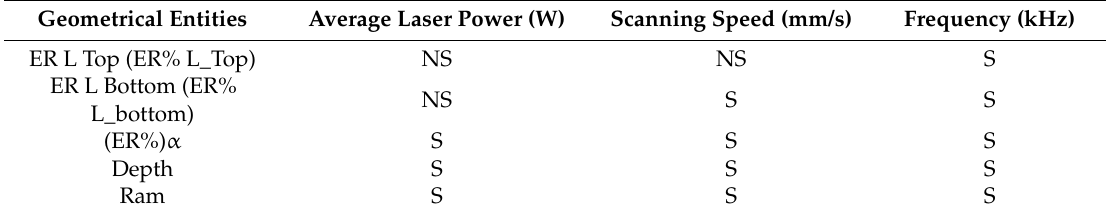
Table 2. Significance of factors vs. geometrical